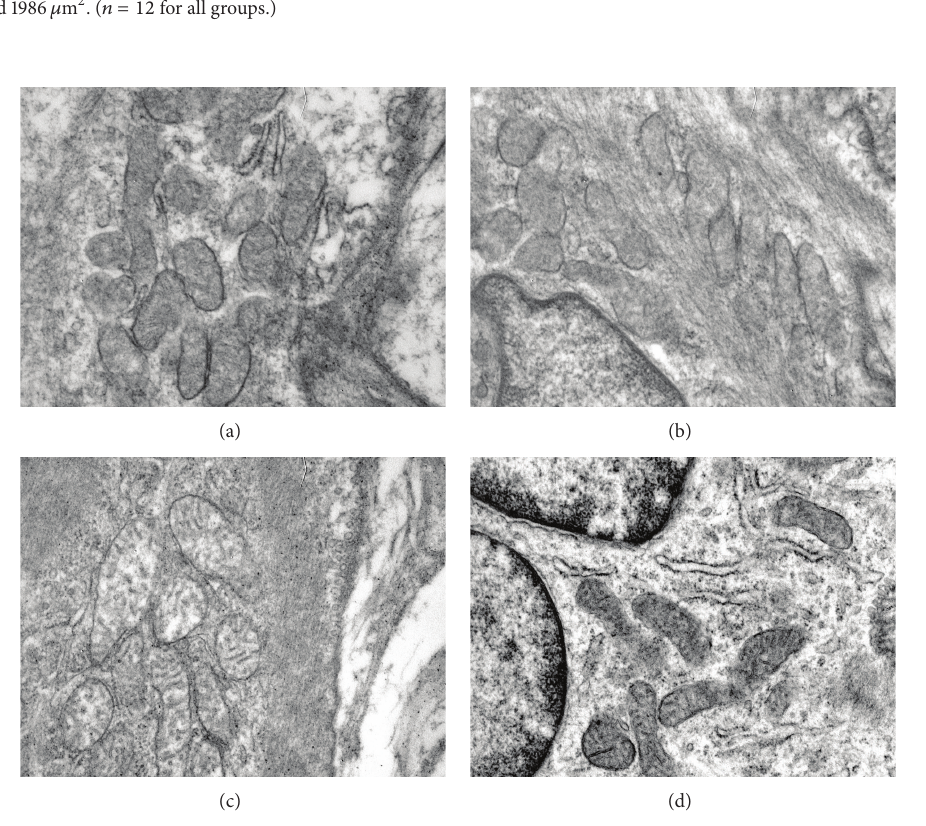
Figure 4: (a) Microphotograph of mitochondria in Ctr group, structure of membranes, and crests without changes and maintaining normal shape and size (arrow), 27800x; (b) Ctr + Ator group showing no changes in shape and size, 21560x; (c) AI group, showing an expansion of the intermembranous space, disorganization of crests, and turbid tumefaction (arrow), 27800x; (d) microphotograph of thoracic aorta of AI-Atorv group, showing mitochondria with unharmed membranes and normal mitochondrial crests,